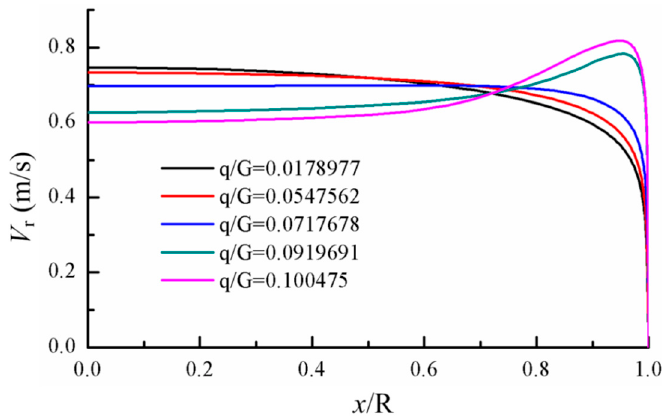
Figure 19. Distribution of the turbulent viscosity ( x/D = 26).